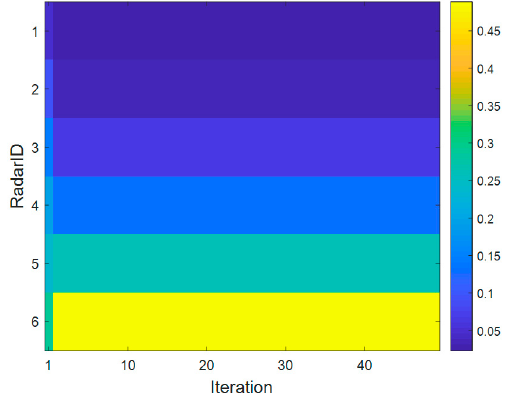
Figure 9. Radar SINR convergence performance.